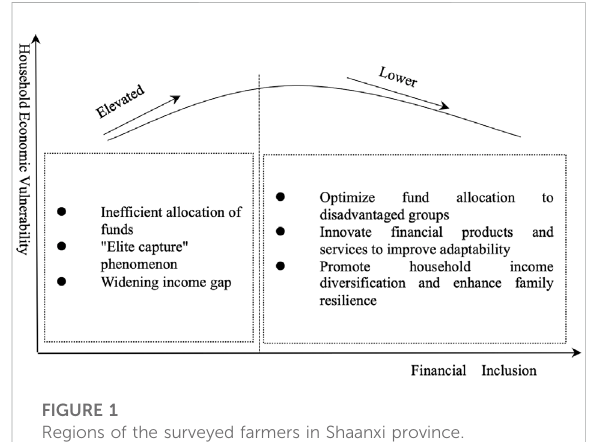
FIGURE 1 Regions of the surveyed farmers in Shaanxi